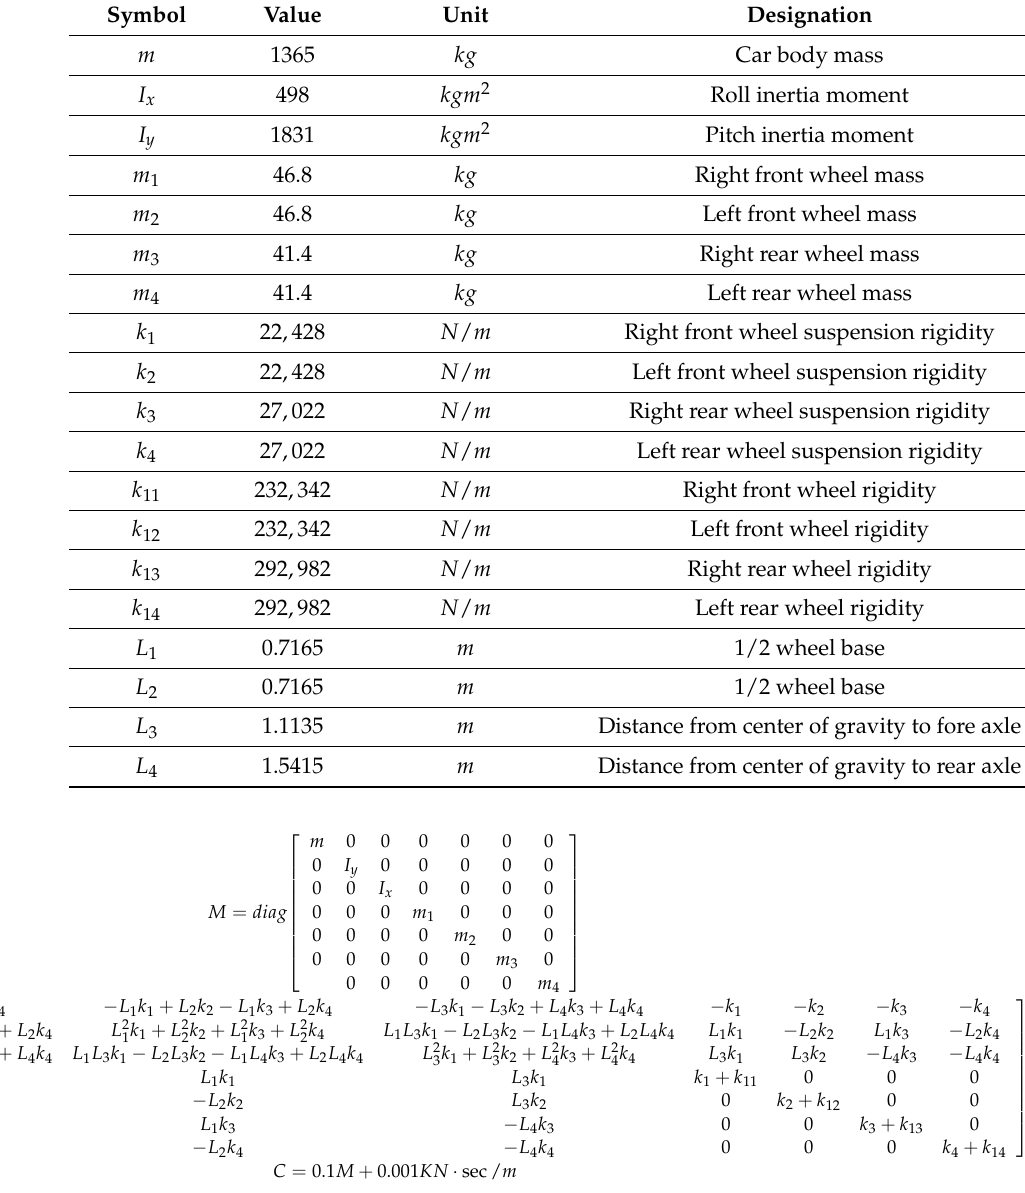
Table 3. Parameter look-up table of seven-DOF car